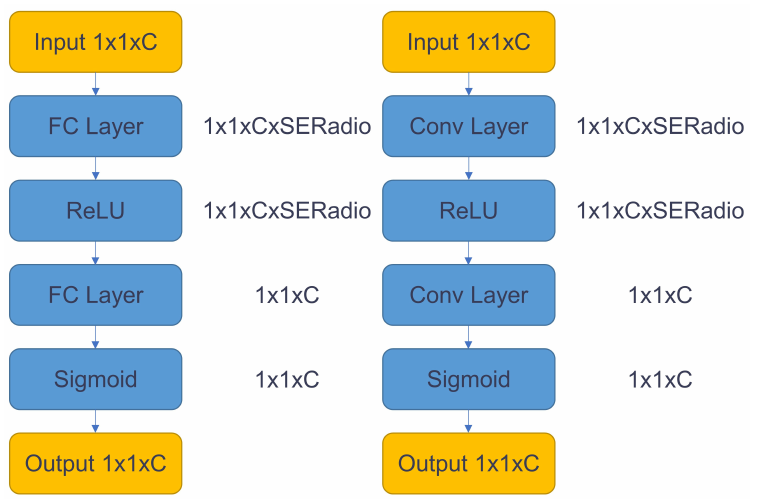
Figure 3. Use of 1 × 1 convolution to replace FC layers in SE module.